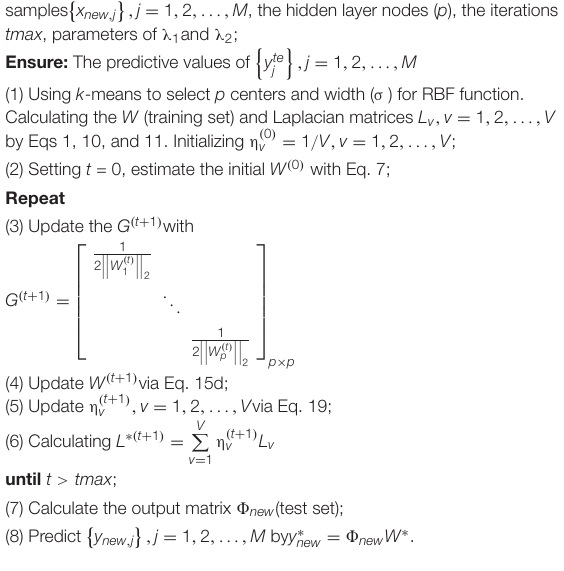
Algorithm 1 | Algorithm of multiple Laplacian-regularized RBFN